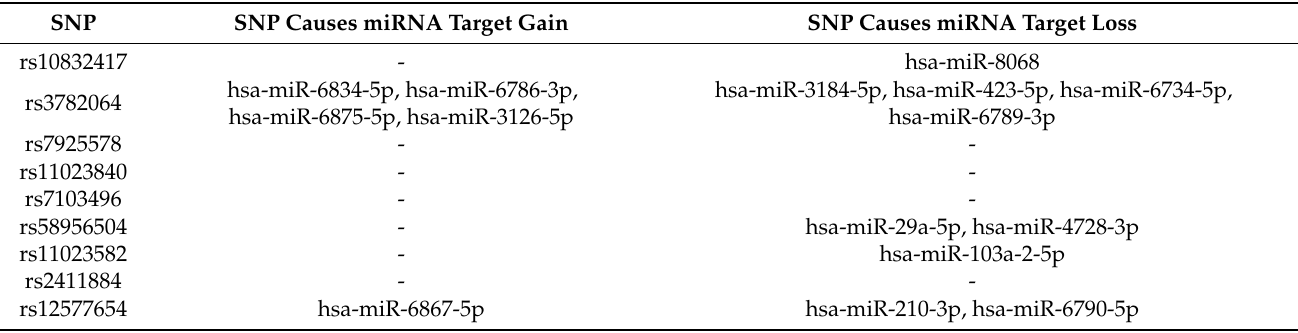
Table 1. The potential impact of each KCNQ1OT1-SNP on the establishment or destruction of the miRNA-binding site.